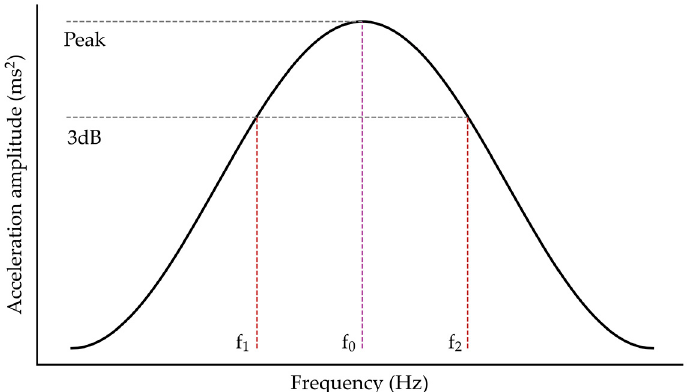
Figure 8. Illustration of calculation of damping ratio of a SDOF peak using.